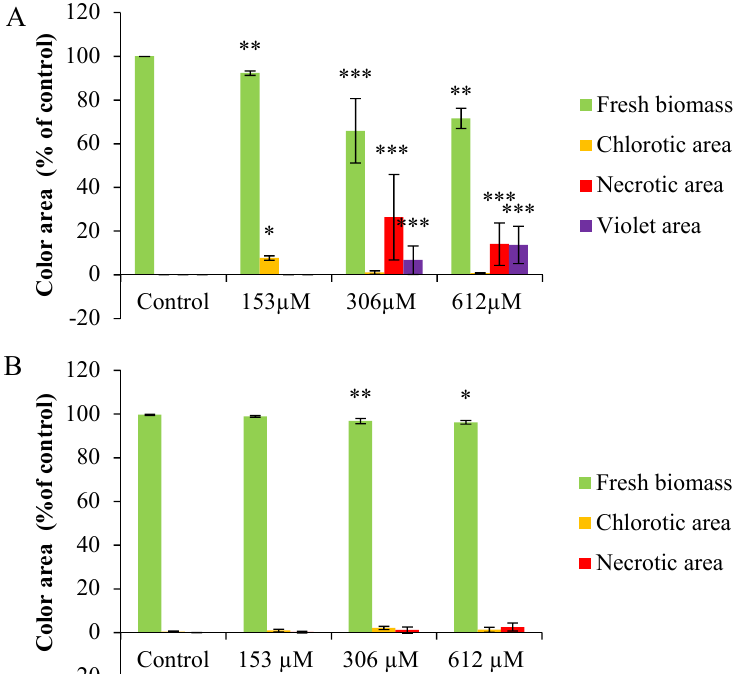
Figure 5. Colorimetric analyses of the leaf area of A. thaliana plants watered ( A ) and sprayed ( B ) with di ff erent concentrations of norharmane (0, 153, 306 and 612 µ M) for 21 days. Asterisks indicate significant di ff erences compared to the control (* p ≤ 0.05, ** p ≤ 0.01, *** p ≤ 0.001). Data are given in percentage with respect to the